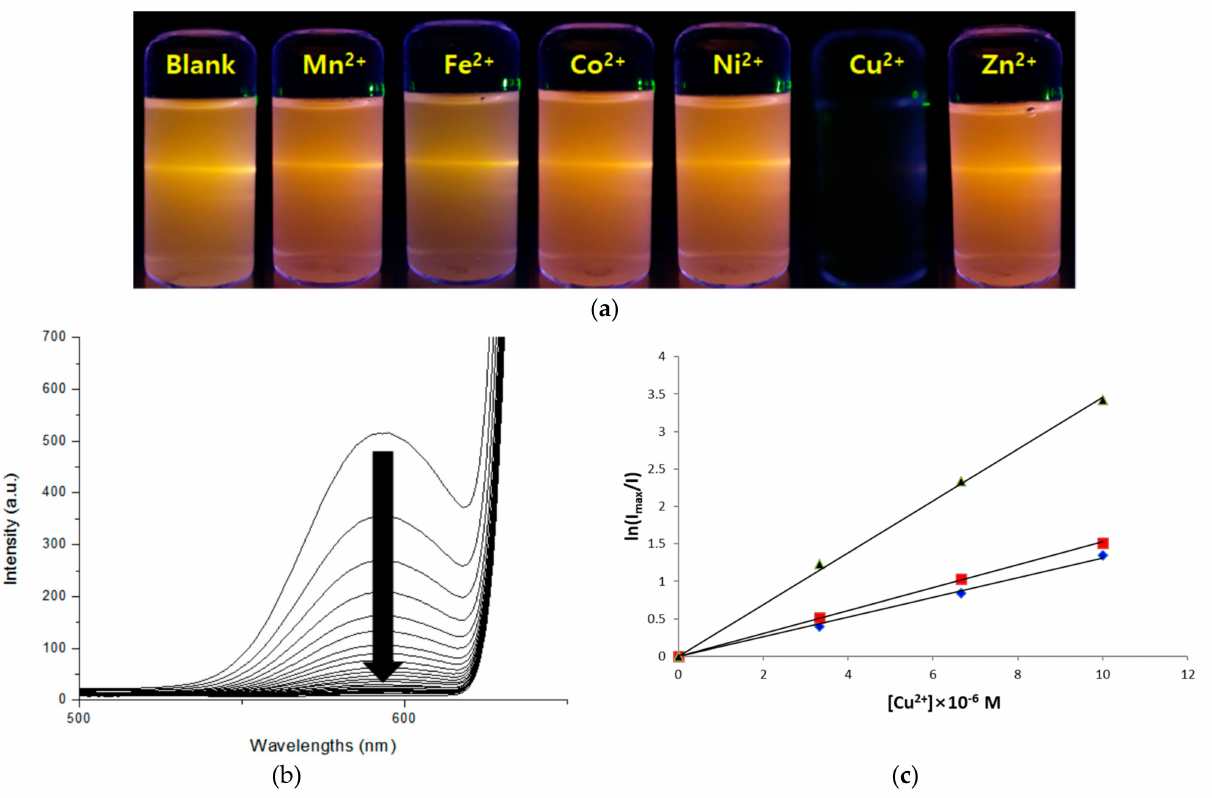
Figure 6. ( a ) Fluorescence images of the Gly-ZnS:Mn NPs upon addition of corresponding divalent transition metal ions, taken under irradiation of a UV lamp (325 nm). ‘Blank’ refers to NPs only. ( b ) PL spectral changes of the Gly-ZnS:Mn NPs upon addition of a Cu 2+ ion-containing solution. ( c ) Linear fitting diagrams showing the Stern–Volmer relationship between the PL intensity changes and the concentrations of the added Cu(II) ions to the Gly-ZnS:Mn (black), Ala-ZnS:Mn (red), and Val-ZnS:Mn (blue)